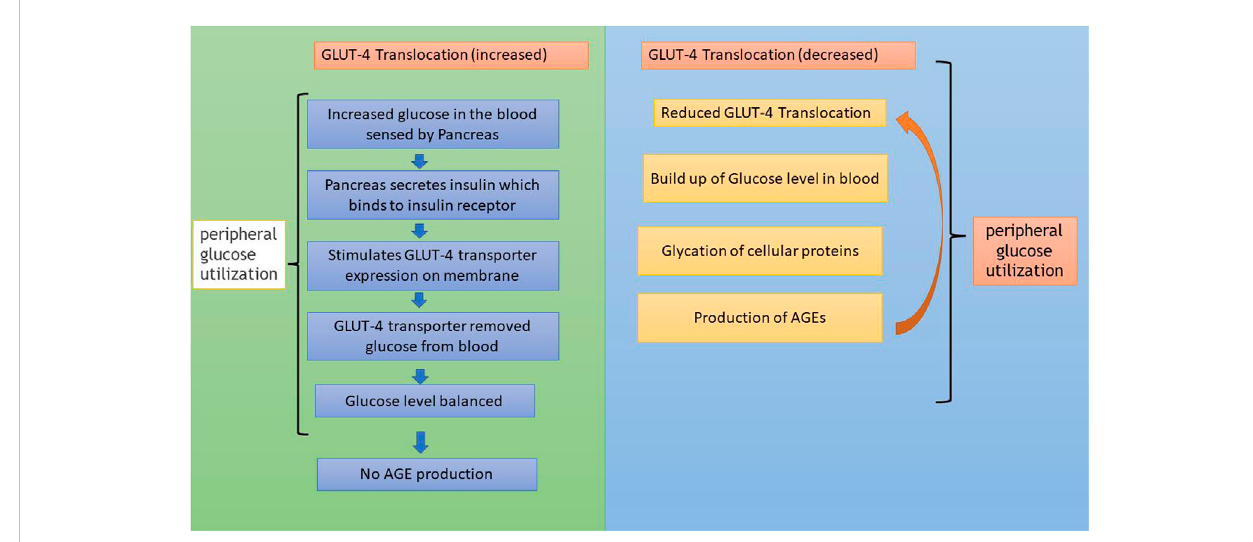
FIGURE 2 Flowchart showing GLUT4 translocation and its relationship to AGE